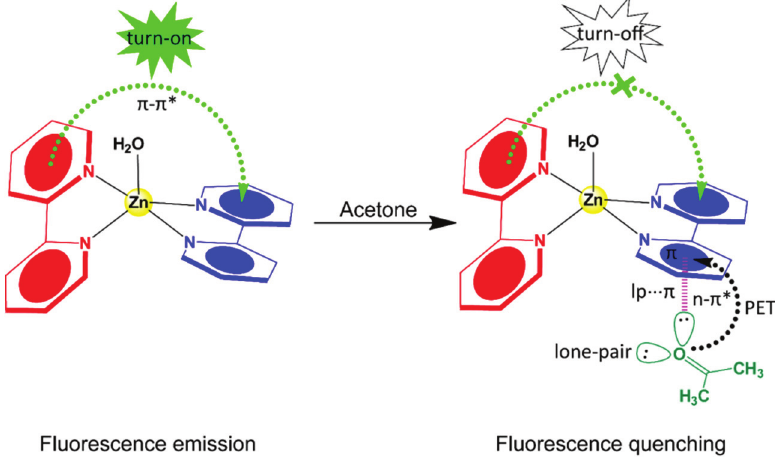
Figure 9. Schematic representation of the mechanism of the fluorescence quenching.